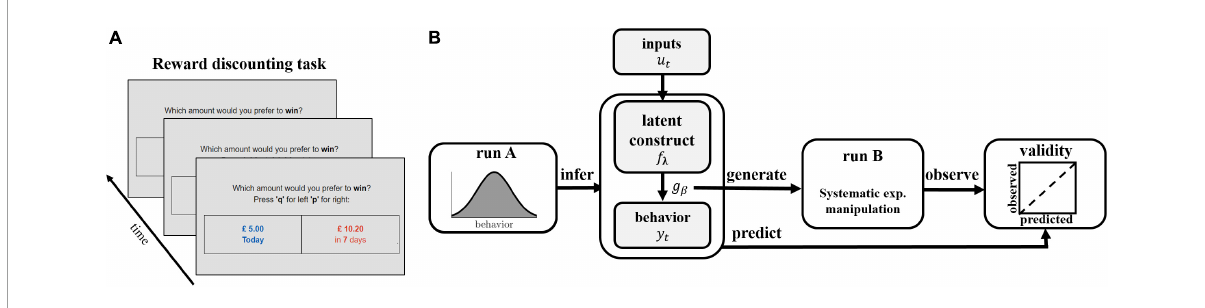
FIGURE1 Schematic illustration of task and experimental framework. (A) Illustration of the reward discounting task. Participants are faced with a series of binary choice trials, in which they are asked to choose between an immediate smaller reward and a delayed larger reward. (B) Illustration of experimental protocol. Participants perform run A of the reward discounting task. Latent discounting models f λ are inferred on each participant’s sequence of observed behavioral choices Y = { y 1 ,..., y T } in run A and used to generate trials of run B. Trials are systematically manipulated by varying experimental inputs u t to induce discounting frequencies ranging from 0.1 to 0.9, based on the expectation of the probability distribution g β . Validity is assessed by comparing predicted and observed rel. choice